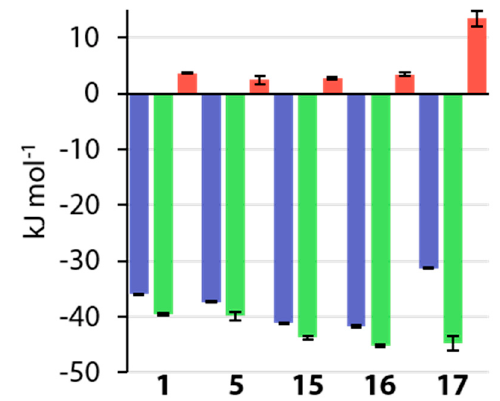
Figure 10. Comparison of thermodynamic signatures of para -substituted compounds 1 , 5 and 15 – 17 .